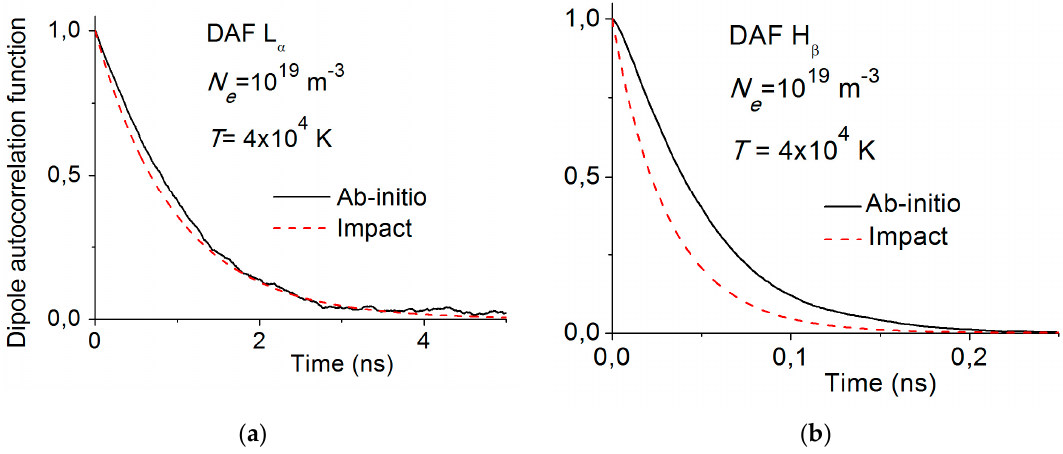
Figure 2. Dipole autocorrelation functions with an ab-initio simulation (solid line) and in the impact limit (dotted line) in a plasma with a density N e = 10 19 m − 3 , and a temperature T = 40,000 K, for ( a ) the L α Lyman transition, and ( b ) the H β Balmer transition.